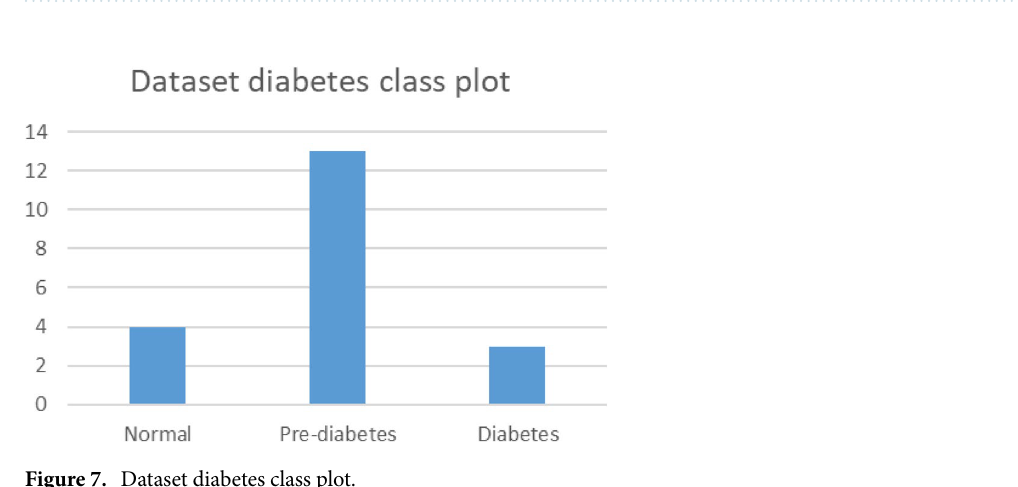
Figure 7. Dataset diabetes class